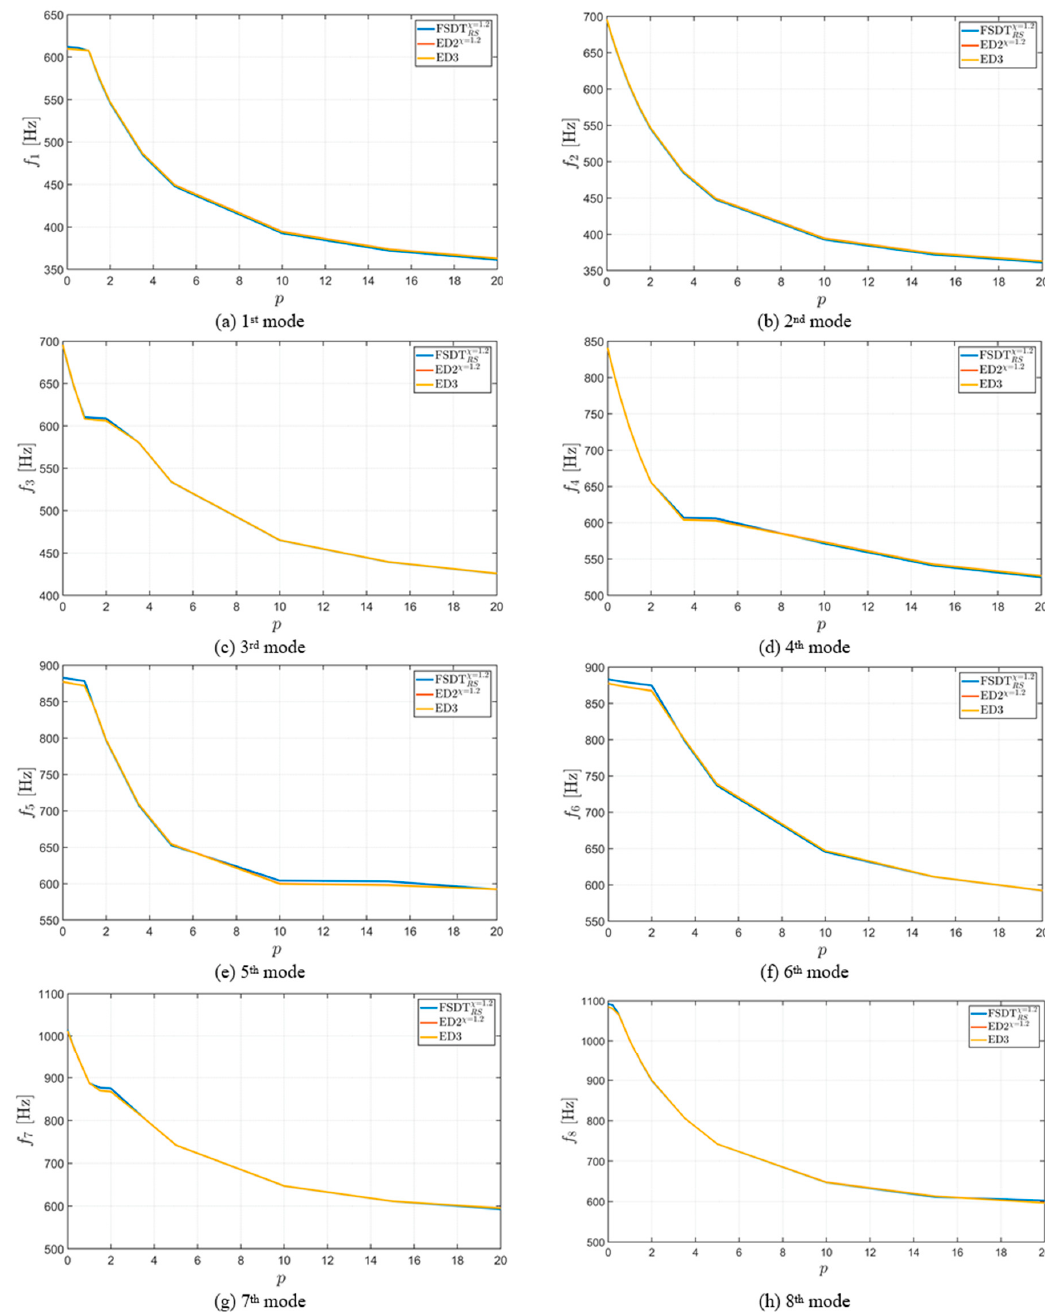
Figure 7. Frequency variations of a CCCC square plate (Figure 3a) made of one lamina of constant thickness h = 0.1m reinforced by CNTs distributed as in Figure 5a for the different parameters p ( k ) . The mass fraction was w r = 0.05, and the agglomeration parameters µ 1 = µ 2 = 1. The Chebyshev-Gauss-Lobatto grid distribution was employed, with I N = I M = 21. The following mode shapes are considered: ( a ) 1st mode; ( b ) 2nd mode; ( c ) 3rd mode; ( d ) 4th mode; ( e ) 5th mode; ( f ) 6th mode; ( g ) 7th mode; ( h ) 8th